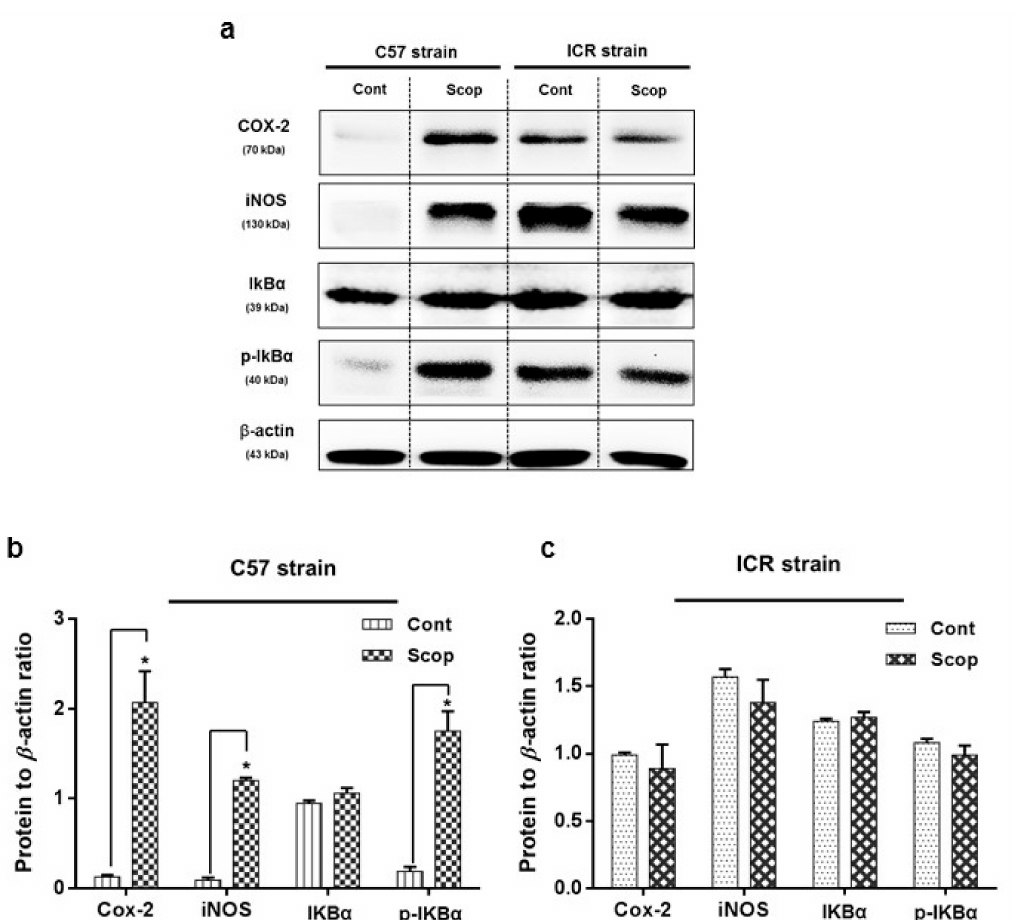
Figure 5. Inflammatory protein expression in hippocampus of scopolamine-induced amnesic models—ICR and C57BL/6 strains: ( a ) inducible nitric oxide synthase (iNOS), cyclooxygenase-2 (COX-2), nuclear factor of κ inhibitor α (I κ B α ) and phosphorylated-nuclear factor of κ inhibitor (p-I κ B α ) levels in the hippocampus determined by Western blotting. Quantification of inflammatory protein expression relative to β -actin in hippocampus of ( b ) C57BL/6 and ( c ) ICR strains. Data are expressed as mean ± SD ( n = 3). One-way ANOVA-Tukey’s multiple comparison test was performed where, * p < 0.05 scopolamine compared with the control